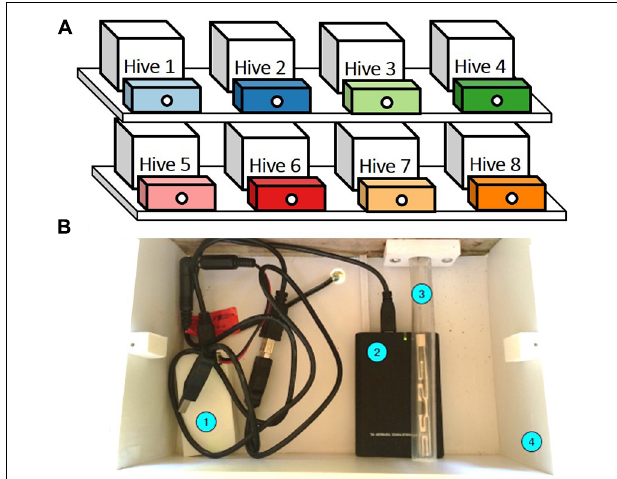
FIGURE 1 | (A) Experimental setup scheme not to scale with four hives in the top shelf and four in the bottom shelf. The RFID systems were placed in a plastic box at the hive entrances. (B) Inside view of the entrance box containing the RFID system. 1, box containing the Intel Edison and Breakout Board; 2, RU-824 antenna; 3, tube connecting the hive to the entrance, and 4, protective plastic